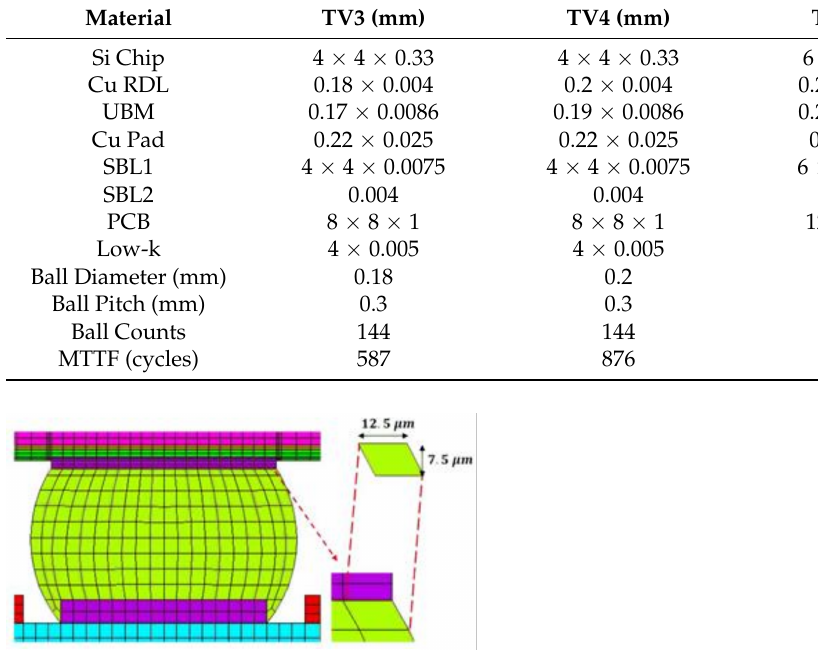
Figure 2. The critical mesh